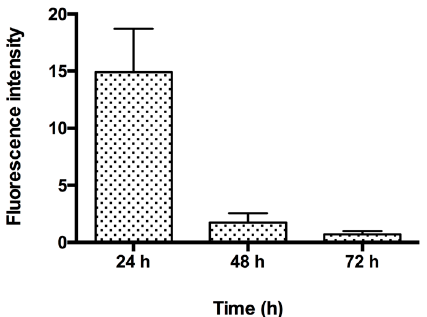
Figure 3. The fluorescence intensity of RITC ‐ NPs in hGECs after co ‐ incubation for 24 h, followed by another 24 and 48 h incubation in the nanoparticle ‐ free media. Error bars represent the standard deviation of three replicates.